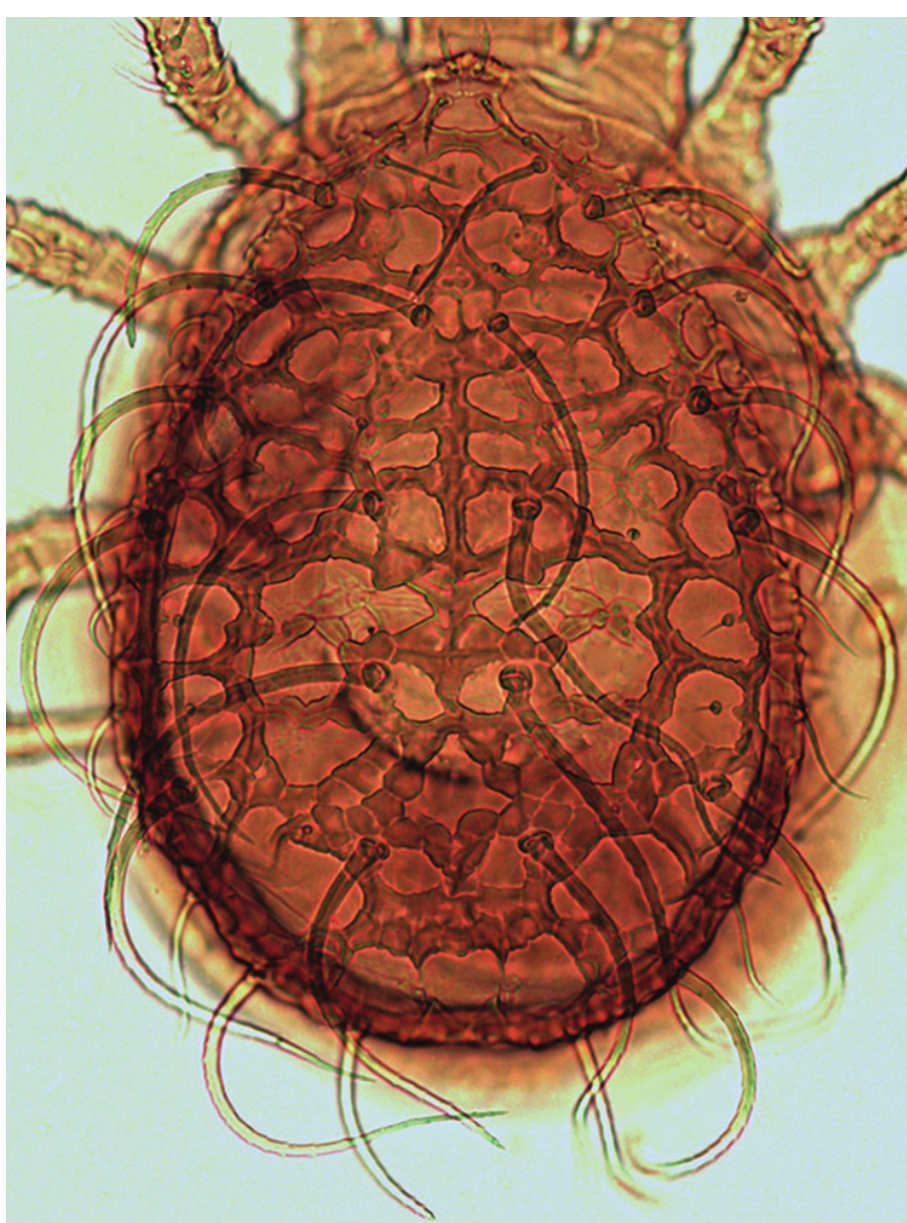
Plate 17. Ameroseius georgei , female, dorsal idiosoma (pressed